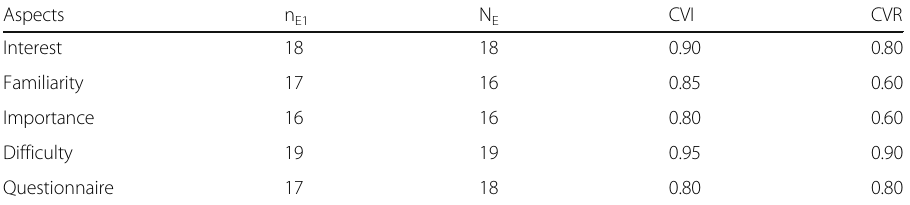
Table 2 Content Validity Ratio of Validated Questionnaires for Learners ’ Perception of Textbook- Assigned Topics